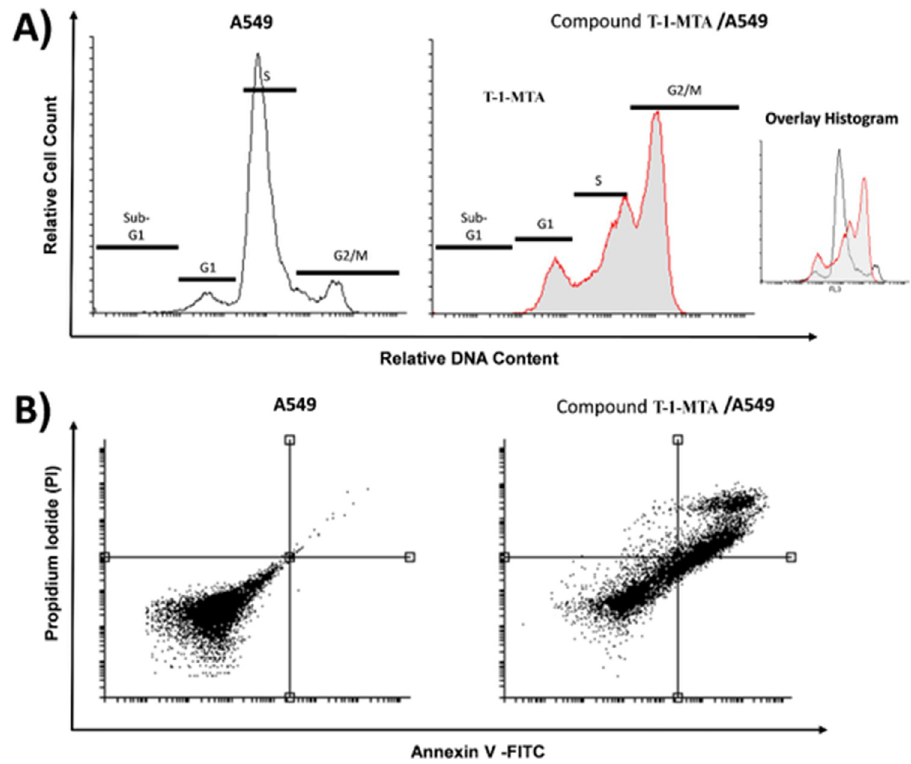
Fig 19. Flow cytometric analysis of cell cycle phases and apoptosis. ( A ) The representative histograms show the cell cycle distribution of control (A549), and cells treated with 22.49 μ M (IC 50 value) of T-1-MTA for 72h. ( B ) Flow cytometric charts of apoptosis in A549 cells exposed to T-1-MTA (22.49 μ M) for 72 h.